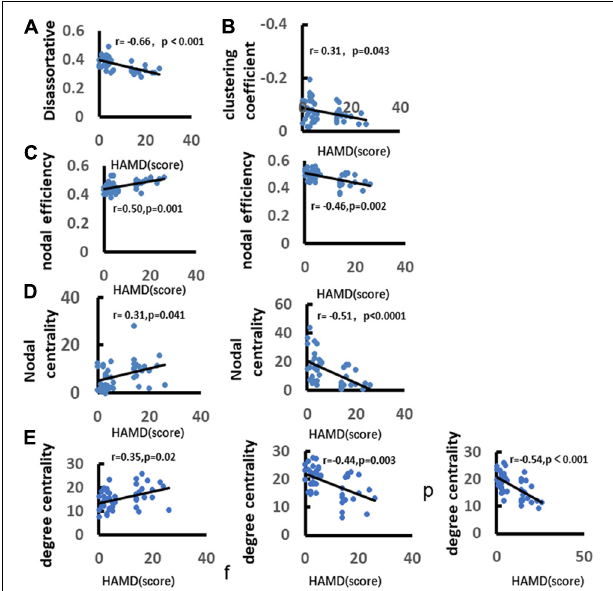
FIGURE 11 | Correlation between depression and alpha band network metrics. (A) Demonstrates significant positive correlation between depression and disassortative. (B) Illustrates significant negative correlation between depression and clustering coefficient. (C) Demonstrates significant positive correlation between depression and nodal efficiency over frontal and parietal lobes. (D) Demonstrates significant negative correlation between depression and nodal betweenness centrality. (E) Illustrates significant positive correlation between depression and nodal degree centrality. Only the significant correlation would show a trend